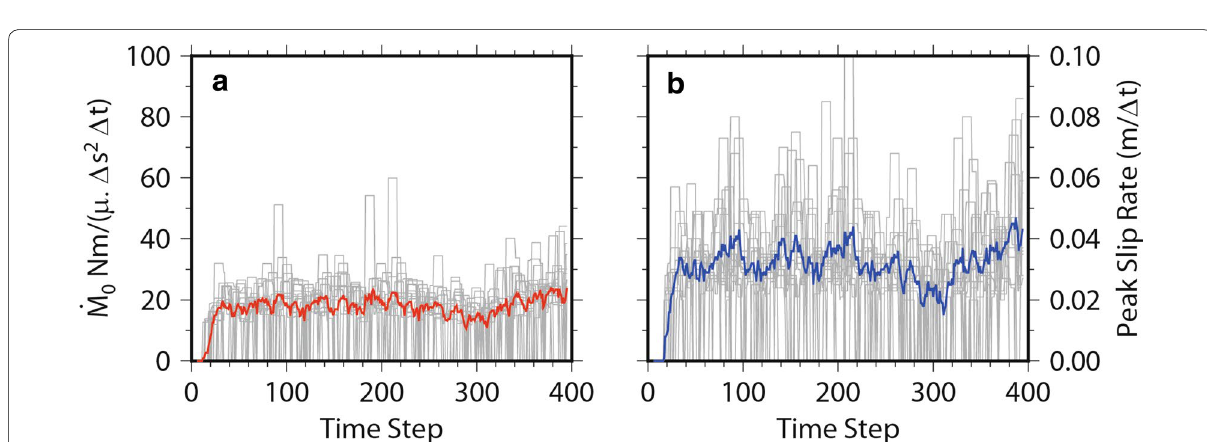
Fig. 10 Peak values of slip rate, averaged over 20 time steps, from the 15 simulations. The overall behavior and local movement are shown in the left and right panels , respectively. The averages of all the simulations are shown by bold